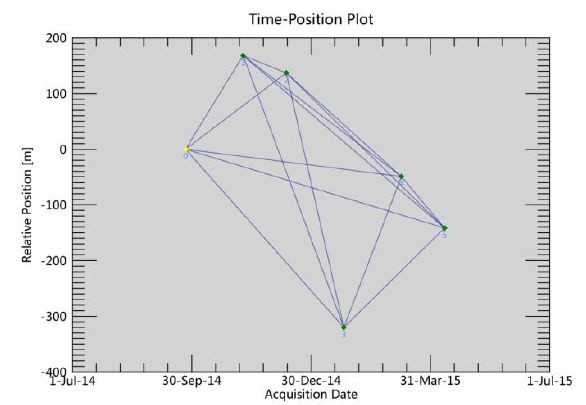
Figure 3. Time and space baselines of the interferogram of TerraSAR After processing interference completed,phase unwrapped for all the relative orbit refining and flatting again.At last we got the series displacement by SBASI inverting.From figure5 and figure6 the average settlement rate for the West Coast